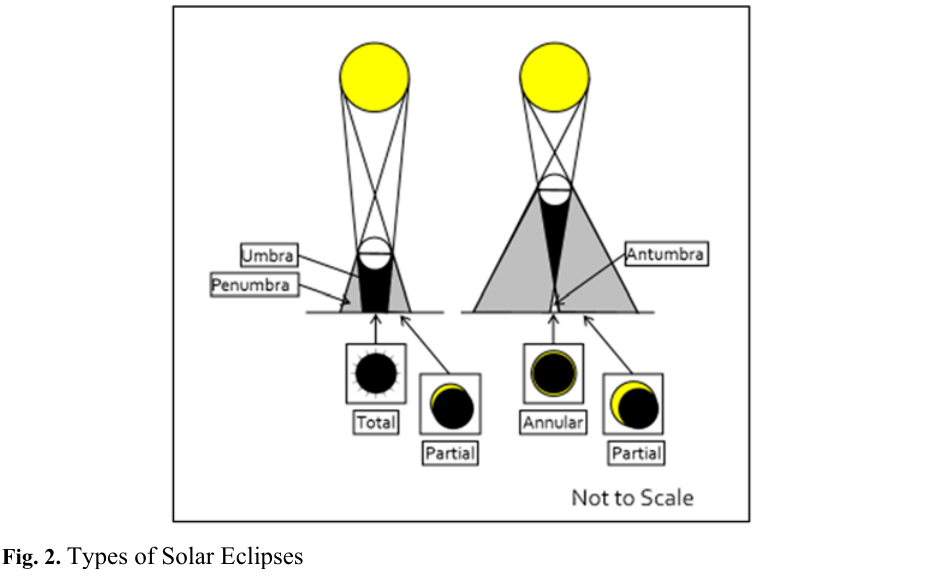
Fig. 2. Types of Solar